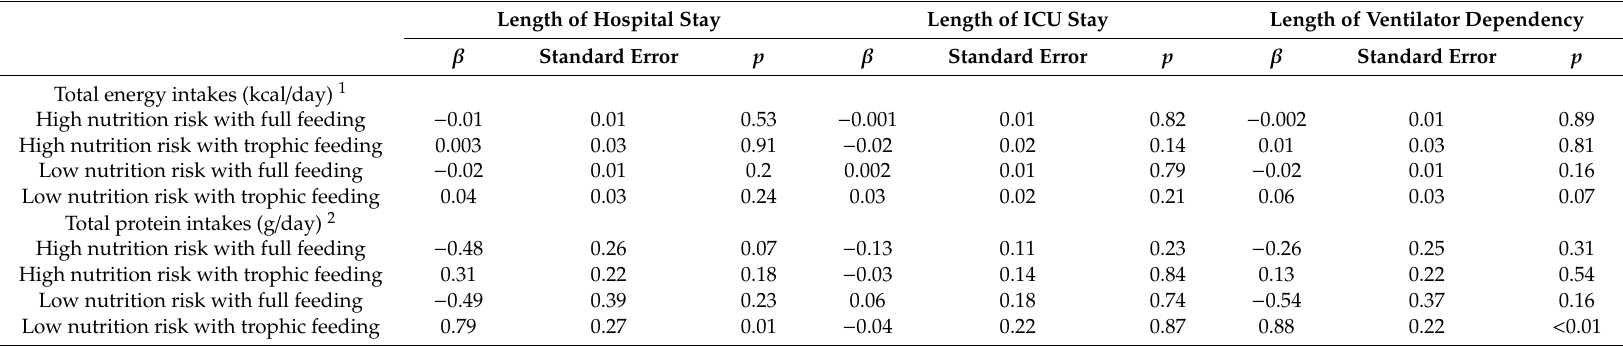
Table 3. Multiple linear regression analysis with length of hospital stay, length of intensive care unit stay, or length of ventilator dependency as the dependent variable in high and low nutrition risk critically ill patients treated with full or trophic feeding after adjusting for potential